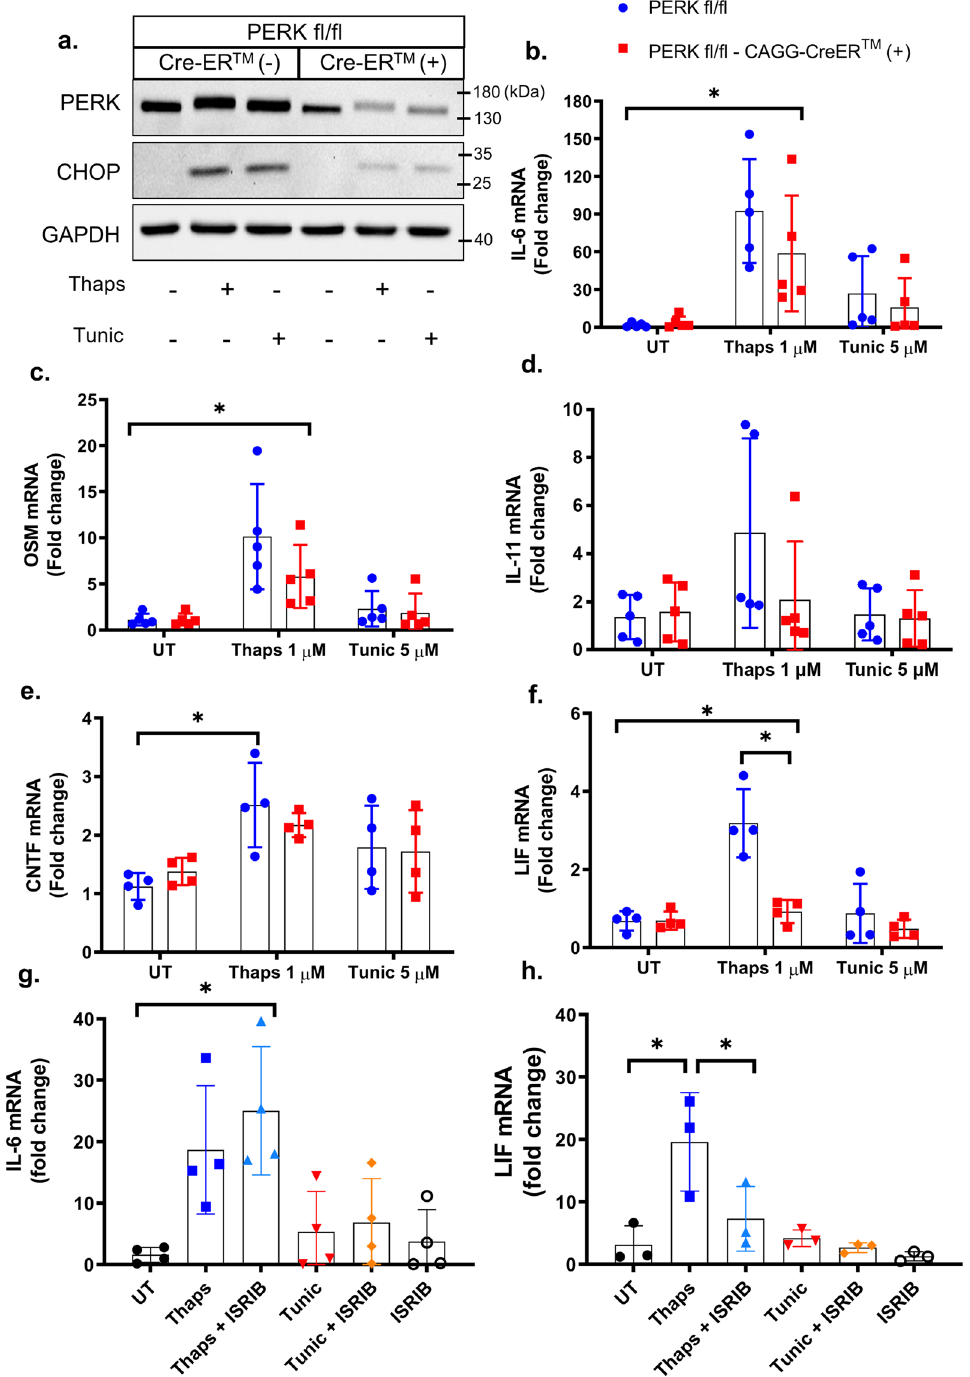
Figure 6. PERK-dependent regulation of the IL-6 family in macrophages. Bone marrow-derived macrophages were isolated from PERK fl/fl and PERK fl/fl × CAGG-CreER TM littermates. ( a ) Macrophages were pre-treated with 1 μ M 4-OH-tamoxifen for 48 hours to delete PERK. Subsequently, cells were treated with 1 μ M thaps and 5 μ M tunic for 4 hours followed by immunoblotting. ( b–f ) Cells were treated as in ( a ) and mRNA expression was analyzed by qPCR. ( g , h ) Wild-type macrophages were pre-treated with 0.5 μ M ISRIB for 30 minutes prior to ER stress stimulation with 1 μ M thaps or 5 μ M tunic for 4 hours followed by qPCR. N = 3–5, * P ≤ 0.05. Full-length blots are presented in Supplementary Fig. in an autocrine-dependent fashion. In this case, ER stress may quickly induce cytokines that ligate JAK1-coupled cytokine receptors leading to canonical activation of JAK/STAT signaling. STAT1 and STAT3 have been shown to synergize with NF- κ B, which is an important transcription factor driving IL-6 in macrophages 39 . Thus, cytokine